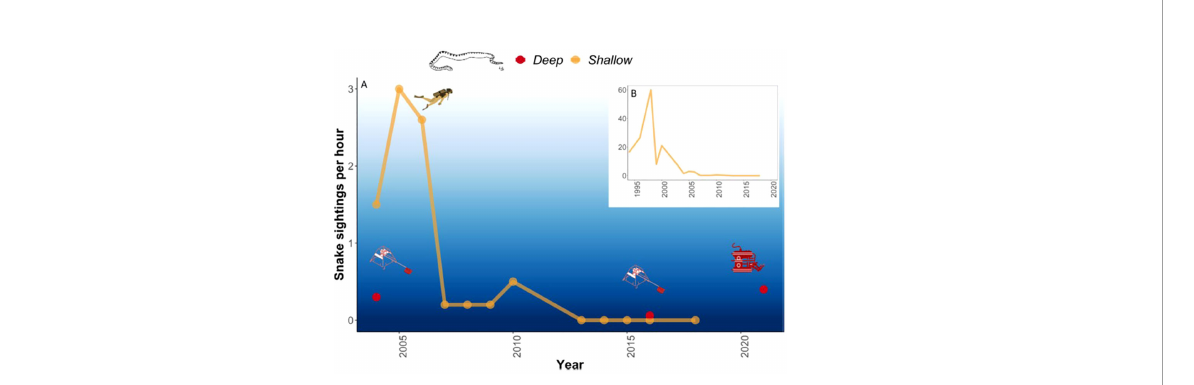
FIGURE 2 (A) Sea snake sightings per hour at Ashmore Reef between 2004 and 2021. Deep-water video observations were made by BRUVS in 2004 and 2016 and ROV in 2021. (B) Historical shallow-water observations of sea snakes recorded per hour at Ashmore Reef since the 1994 (redravn from Somaweera et al., 2021). Diver image courtesy of the Integration and Application Network, University of Maryland Center for Environmental Science (lan.umces.ado/symbols/). Reproduced from Speed et al. (2022).